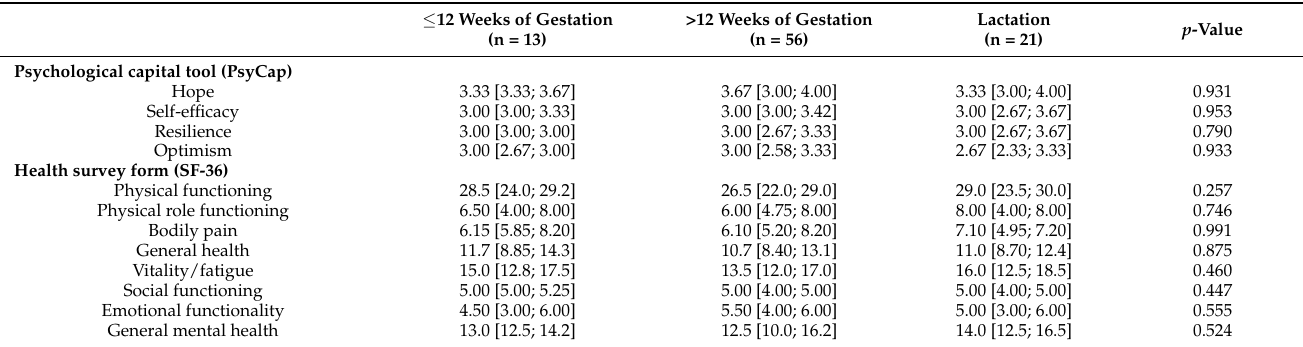
Table 2. Differences in psychological capital and health indexes between